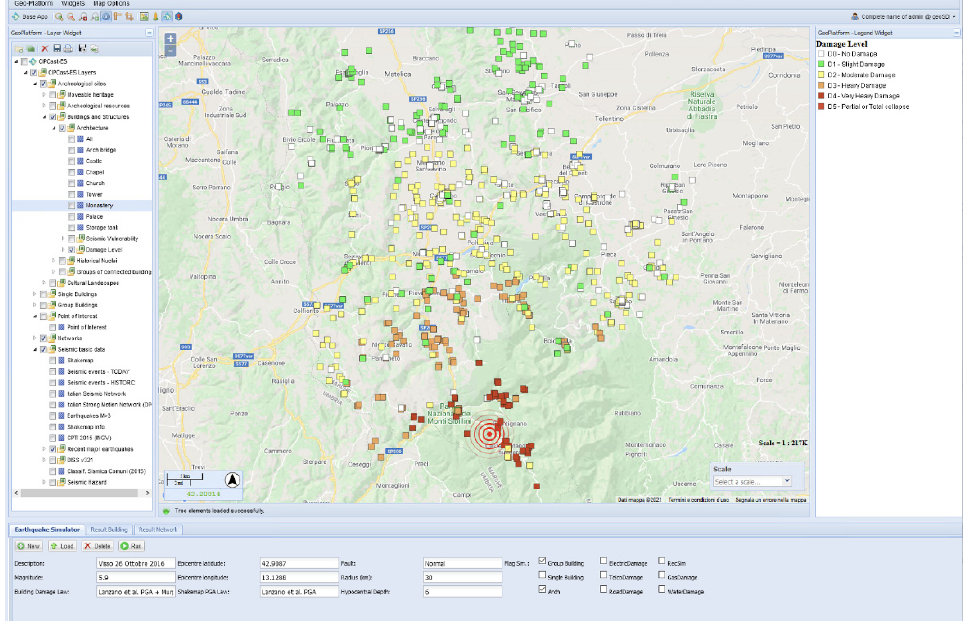
Figure 9. Assessed damages for the CH of Camerino HA after Visso Earthquake (26 October 2016, Mw = 5.9).